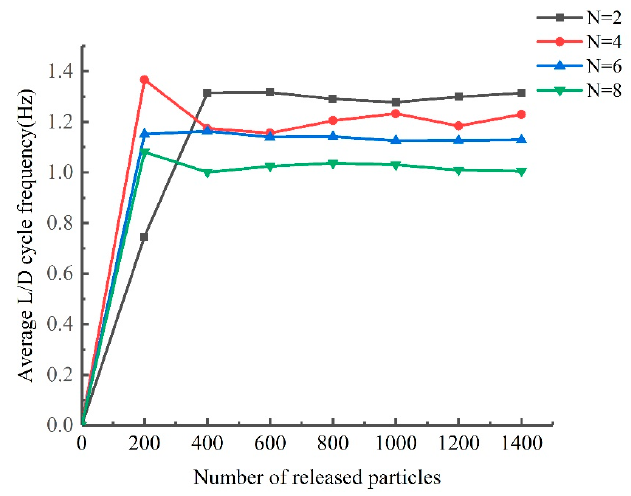
Figure A1. Average L/D cycle frequency of particles as a function of the particle number for PBRs with different numbers of ribs.